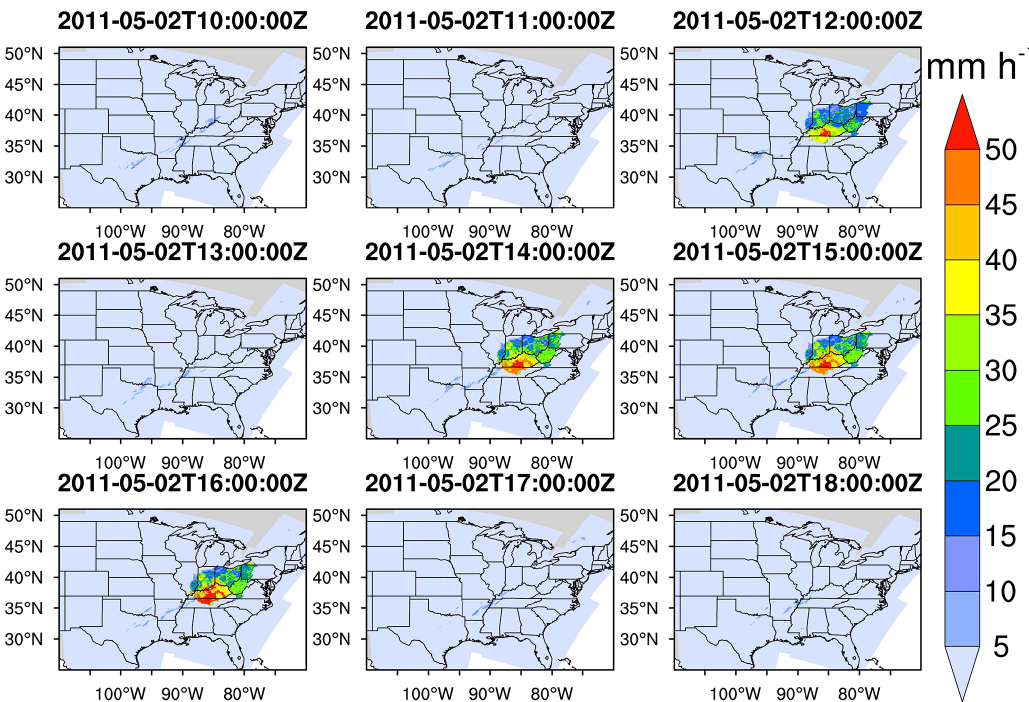
Figure A9. An example of Stage IV erroneous precipitation. Stage IV shows a large area of intense precipitation suddenly appearing at 2011- 05-02T12:00:00Z, which then unexpectedly disappears at 13:00:00Z, comes back abruptly at 14:00:00Z, and finally goes away immediately at 17:00:00Z.